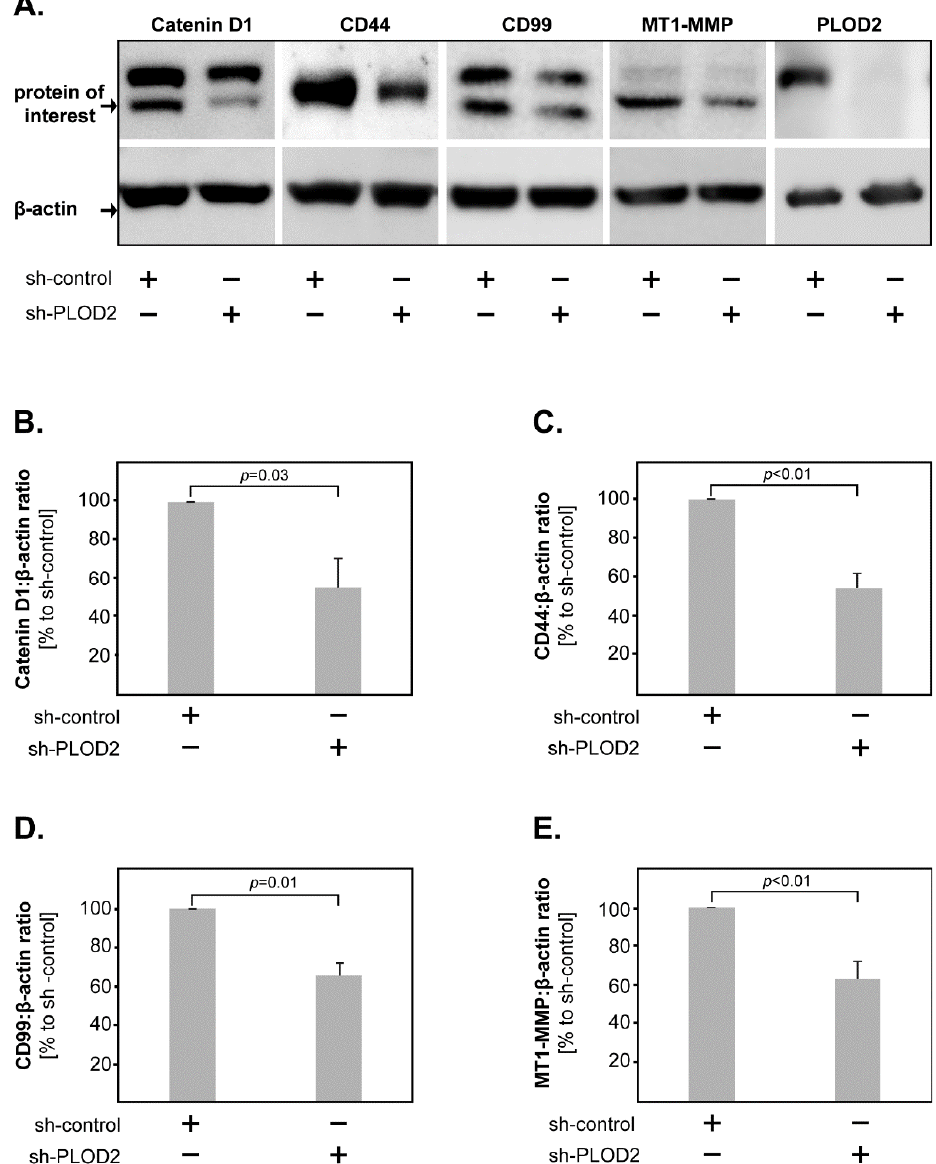
Figure 5. Molecular mechanisms of PLOD2 in GBM. ( A ) Representative western blots of Catenin D1, CD44, CD99, MT1-MMP and PLOD2 levels in sh-PLOD2 versus sh-control GBM cells. Beta-actin was used as a loading control. PLOD2 knock-down significantly decreased the levels of ( B ) Catenin D1, ( C ) CD44, ( D ) CD99 and ( E ) MT1-MMP in GBM cells. Shown are the means + S.D. of at least three independent experiments. Statistical analysis was performed with the paired t -test.